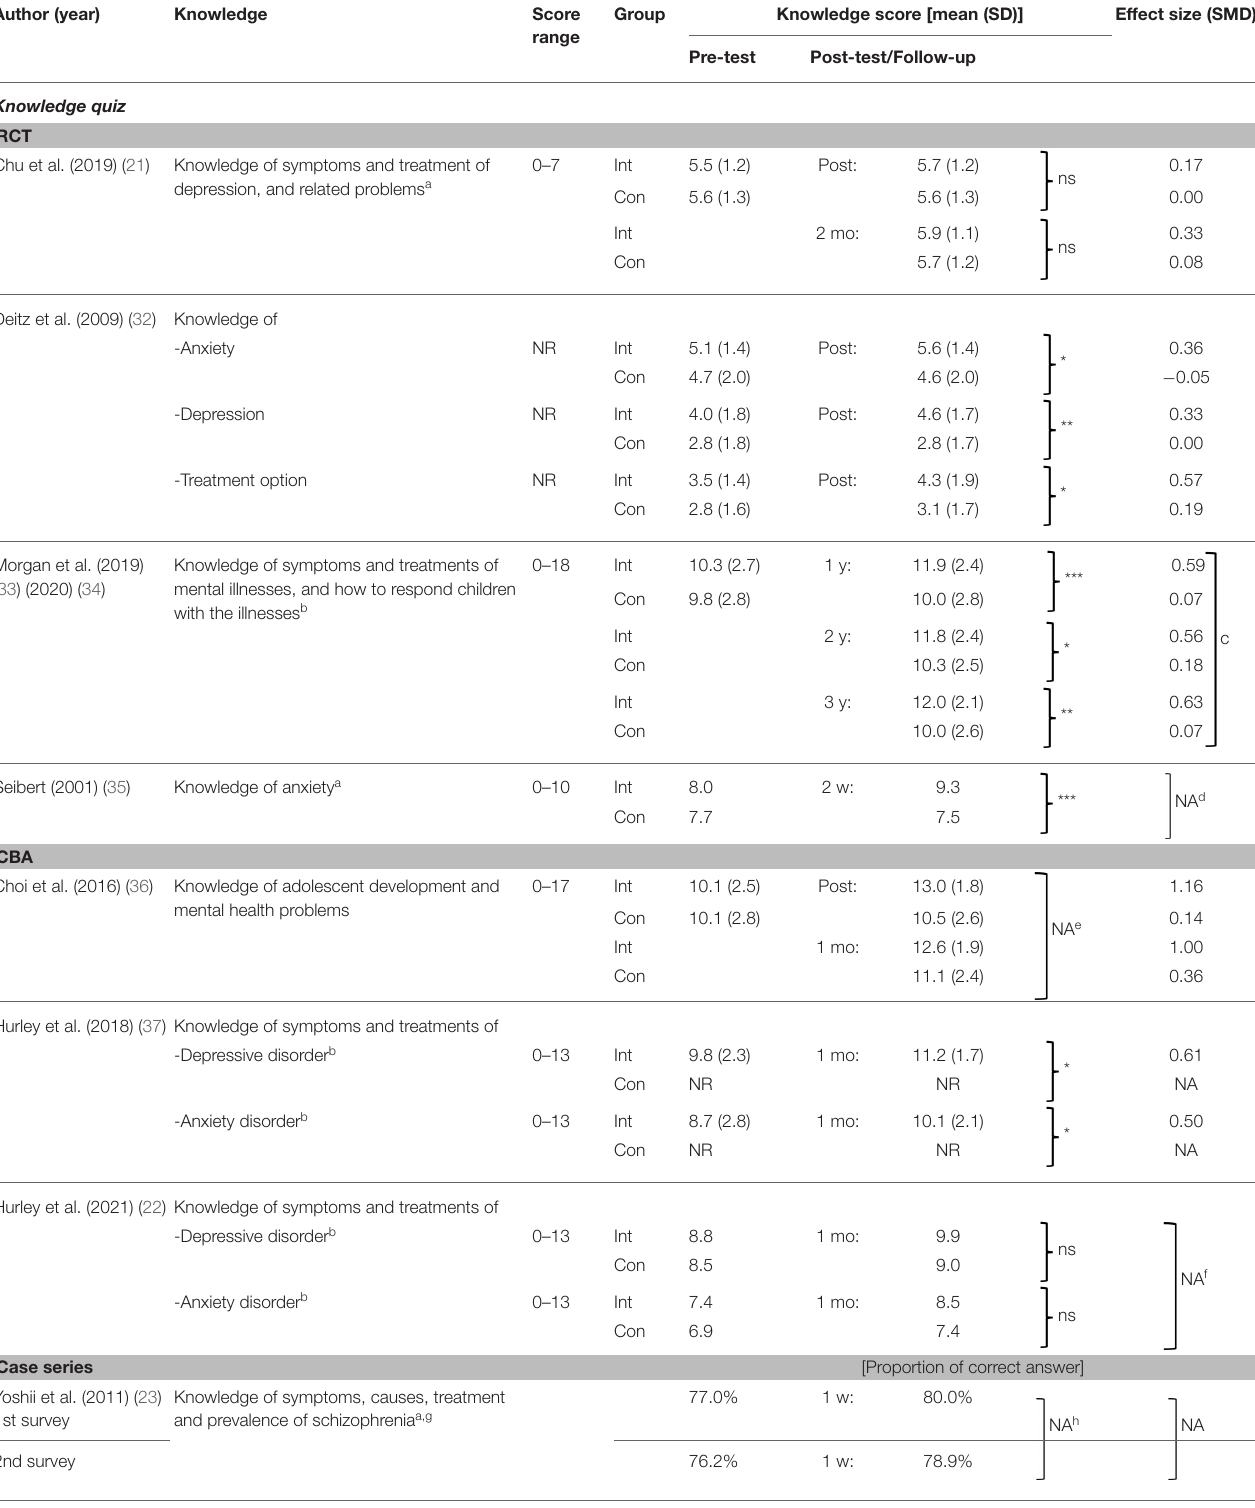
TABLE 4 | Effects on knowledge of mental health/illnesses and their